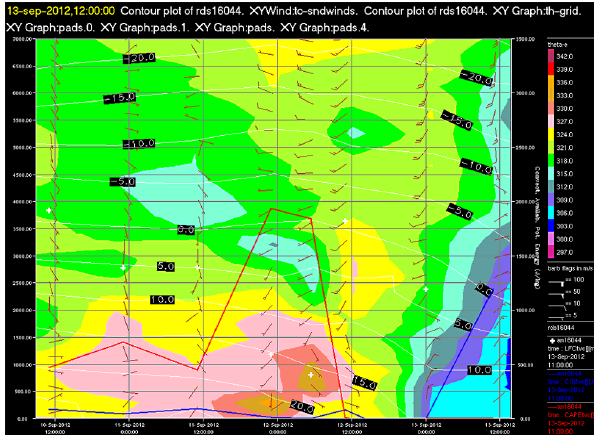
Figure 6. 7km vertical time series (from 10 to 13 September 2012) of all the Udine soundings made by CNMCA with horizontal winds, 2 e (k) in shaded colors and overlapping CAPE (Jkg − 1 ) and CIN (Jkg − 1 ) estimations.